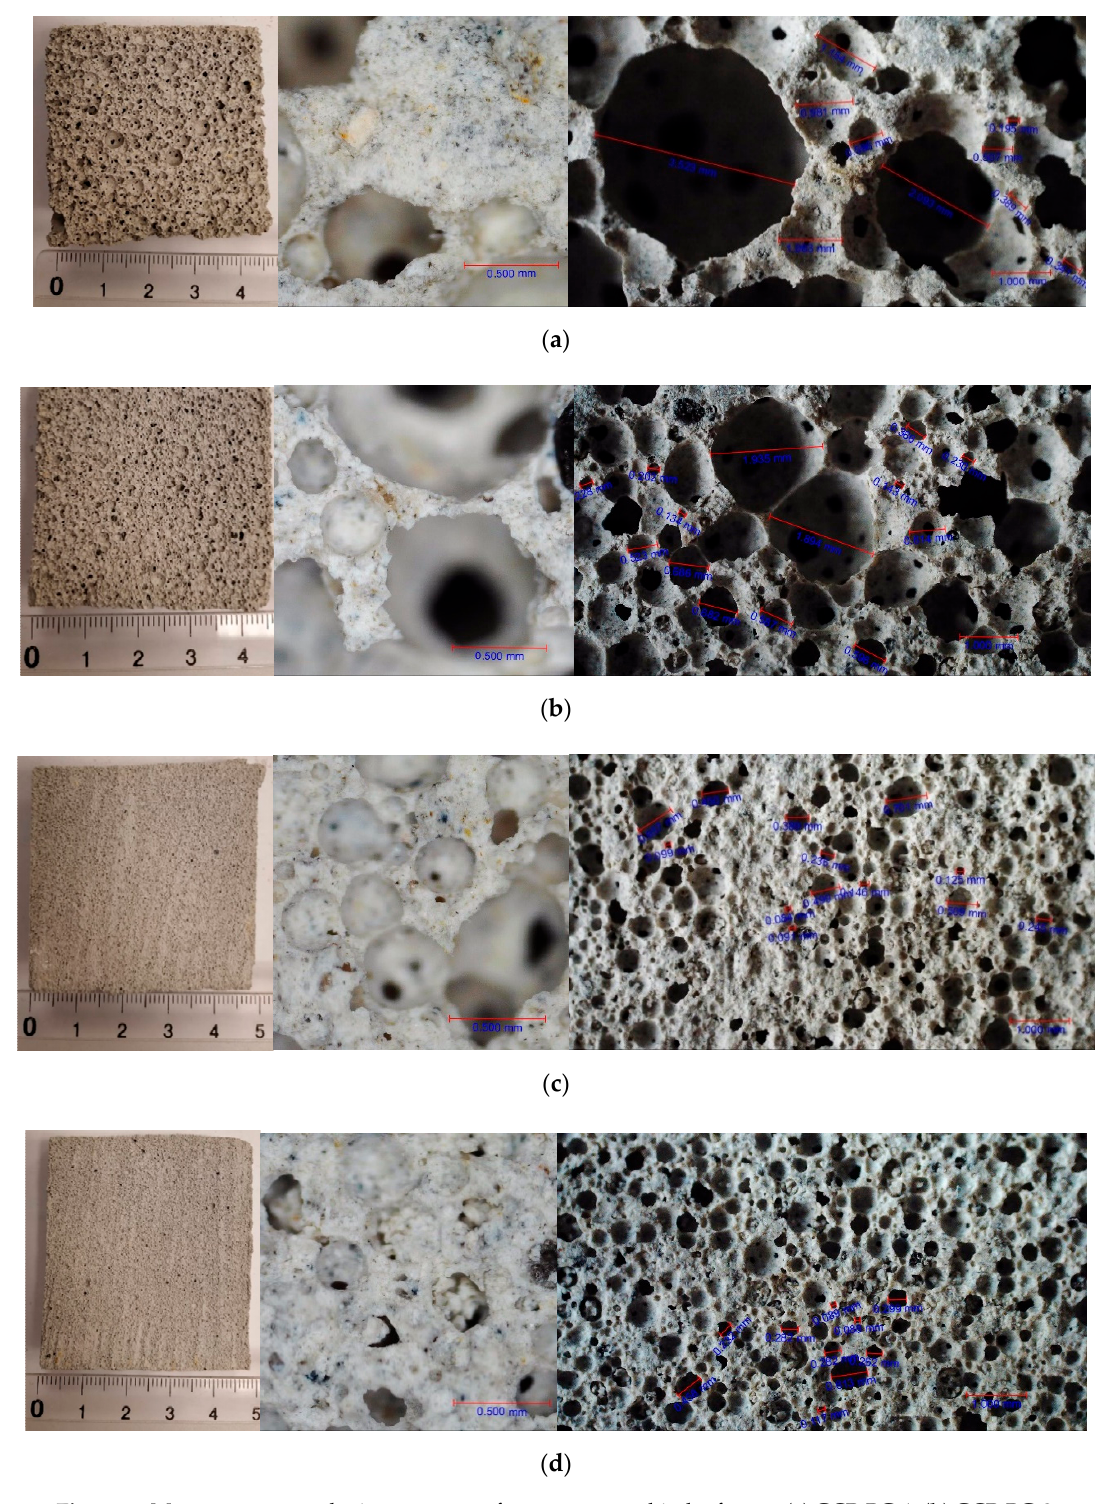
Figure 7. Macrostructure and microstructure of ternary system binder foams. ( a ) GCP-BG-1, ( b ) GCP-BG-2, ( c ) GCP-PG-1, ( d ) GCP-PG-2.